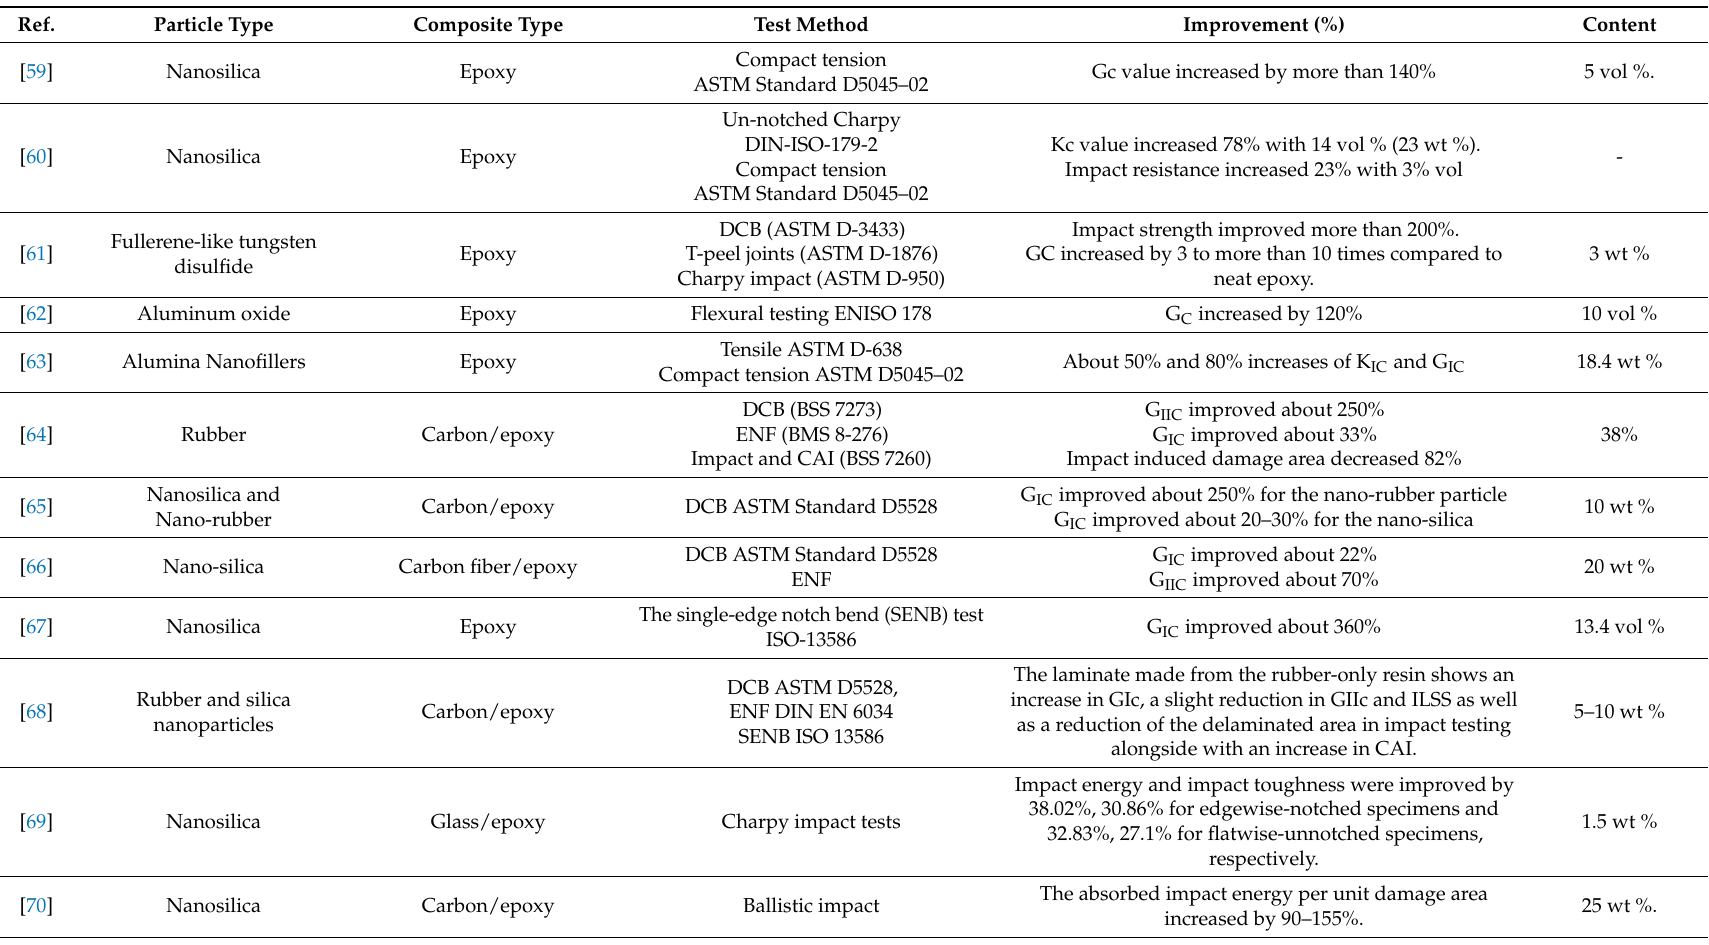
Table 2. Published paper regarding the influence of nanoparticles on fracture toughness and impact response of composite laminates.